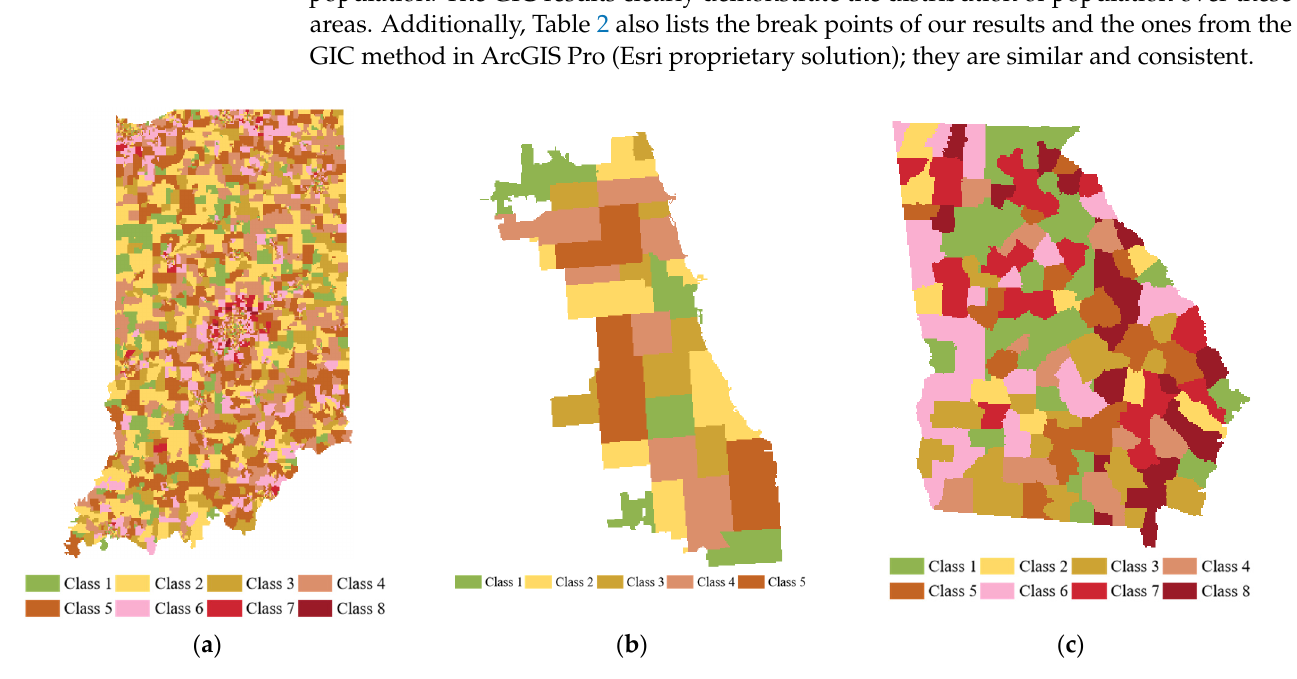
Figure 7. Classification results of population data using GIC for Indiana ( a ), Chicago ( b ), and simulated population data of Georgia ( c ). The larger the class ID, the more the population. Table 2. Break points of GIC for populations of Indiana, Chicago, and simulated population of Geor- gia.